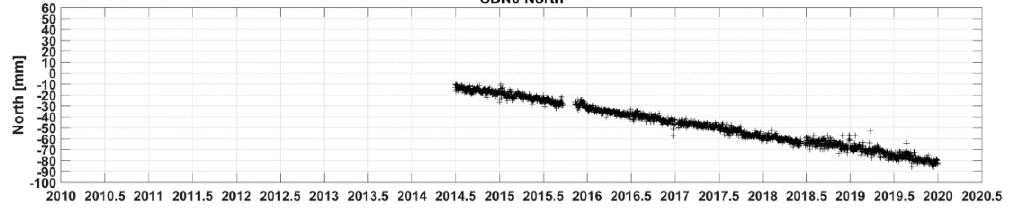
Figure 1. The permanent network of continuously operating GNSS reference stations on the island of Crete, Greece in the centre of eastern Mediterranean ( left ). The CDN0, CRS1, MEN2, RDK1, and TUC2 GNSS sites are operated by the Technical University of Crete. The remaining GNSS reference stations are part of a private HxGN SmartNet RTK network of METRICA S.A. The Sentinel-3A OLC_2_LFR image captured on 7 May 2016 has been used as background in the right image of the network.